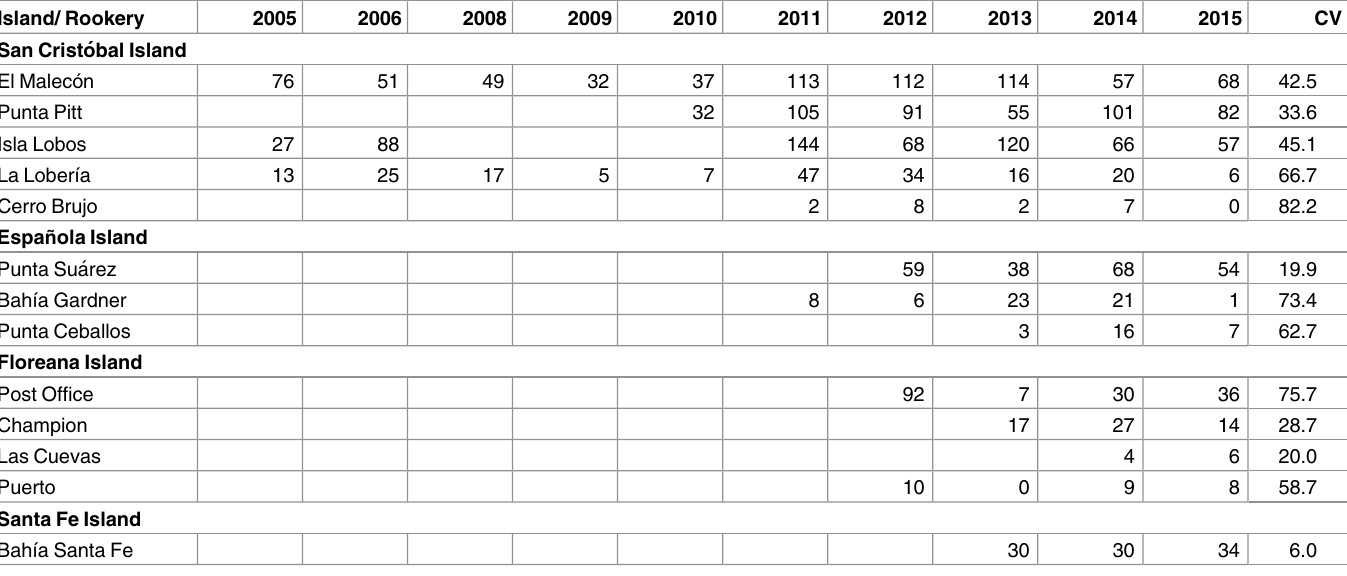
Table 2. Numbers of Galapagos sea lion pups counted in southeastern rookeries of the archipelago. The coefficient of variation (CV) shows the vari- ability in the number of pups counted per rookery throughoutthe years. The mean CV within the southeastern regionis 47.3% Island/